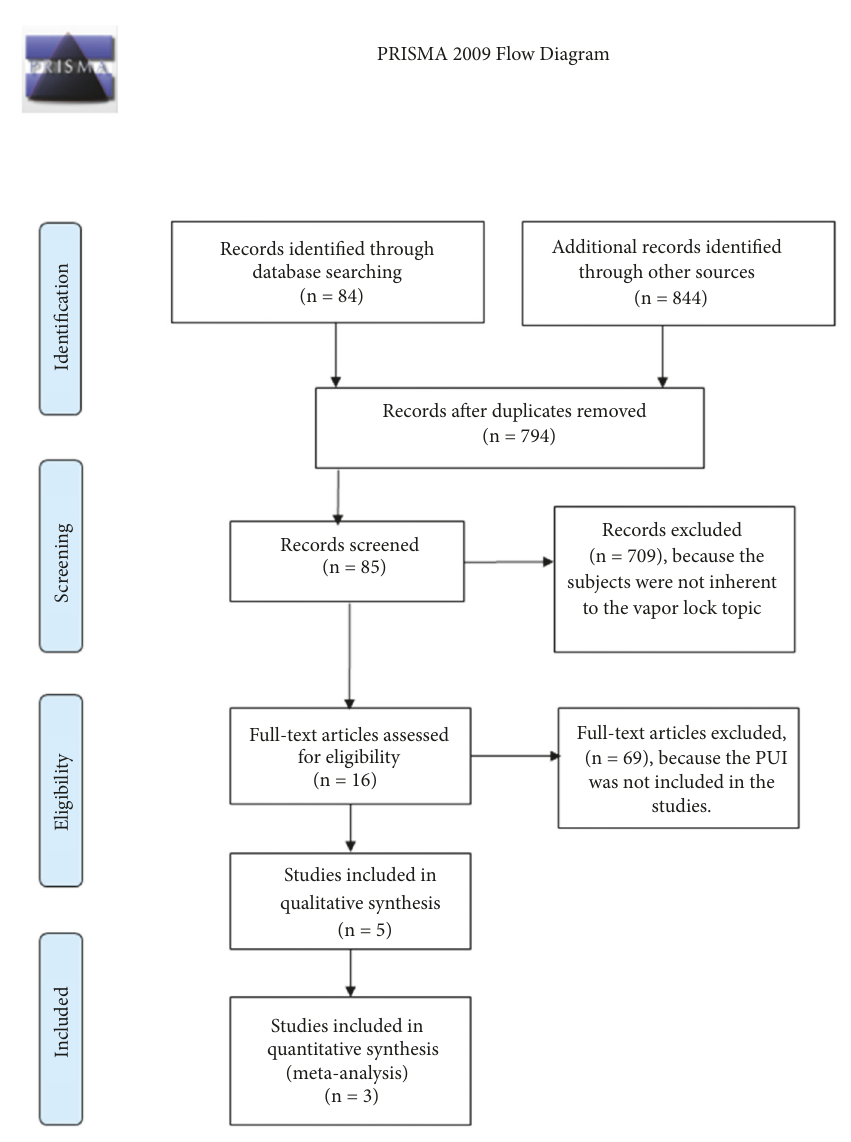
Figure 1: Flowchart describing the selection of studies used for the present systematic review, as described by the PRISMA guidelines.